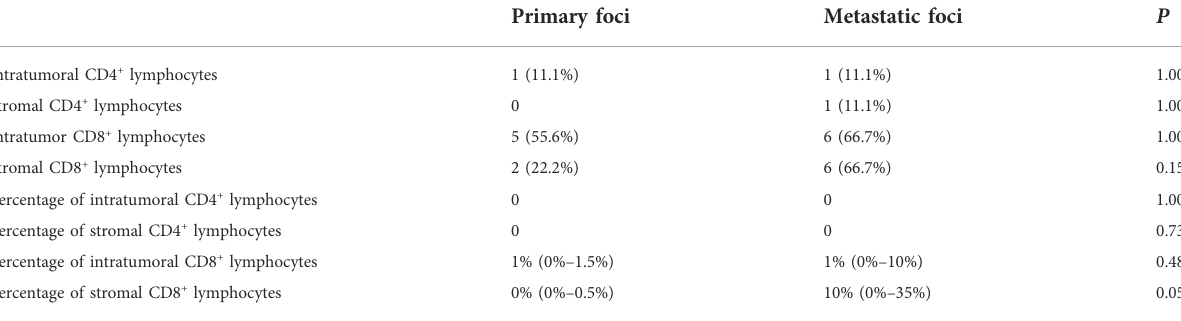
TABLE 6 Differential expression of intratumoral and stromal CD4 + and CD8 + lymphocytes in the primary and metastatic foci of the metastatic